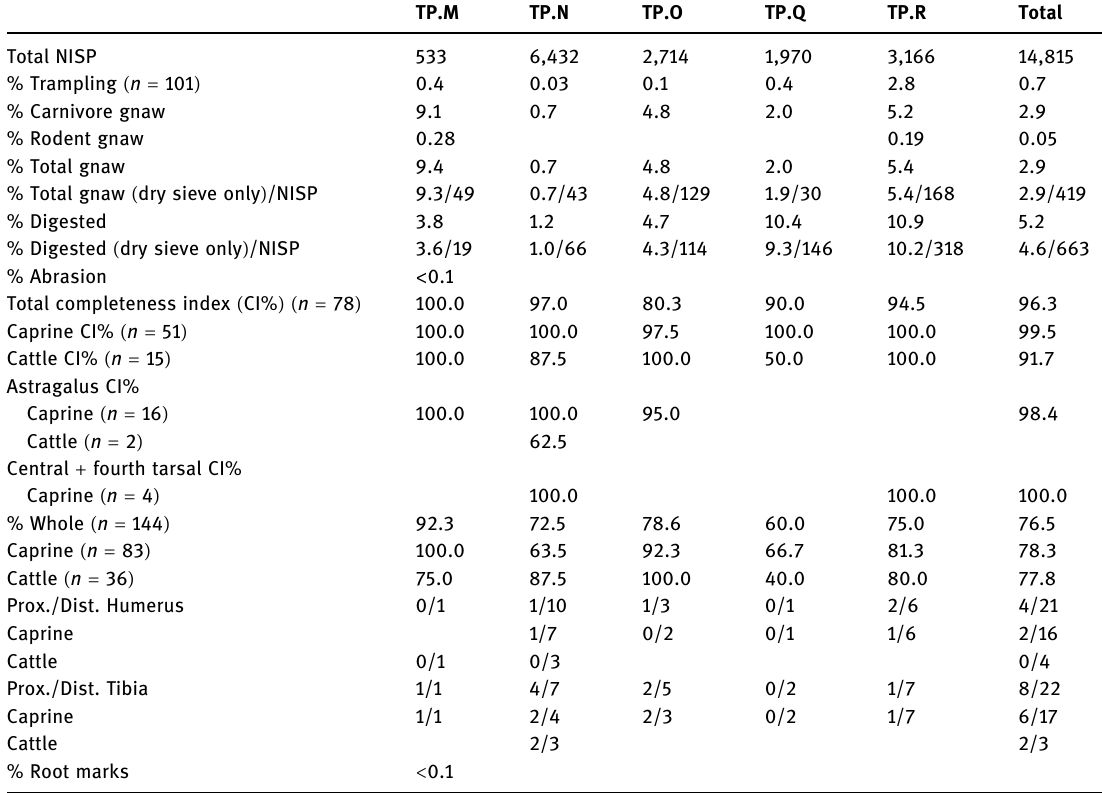
Table 1: Taphonomic characteristics and density - mediated attrition for TP assemblage, by